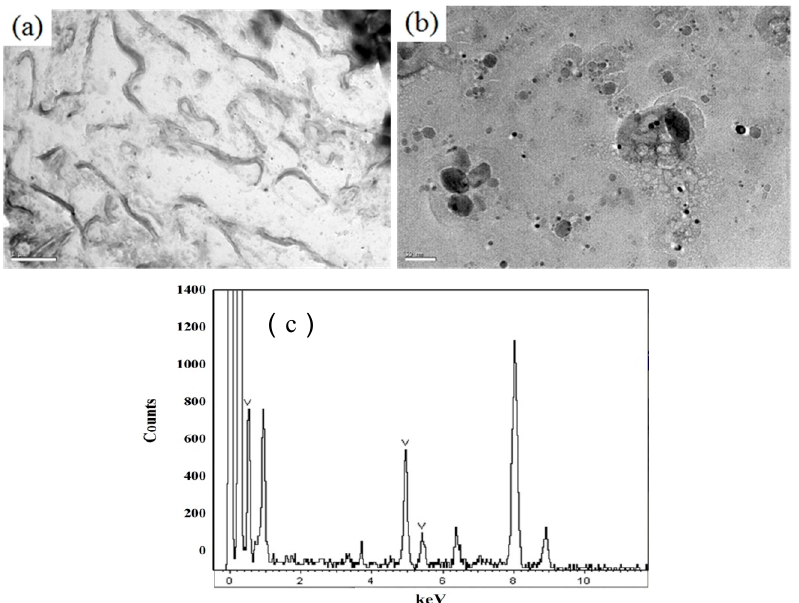
Figure 8. TEM observation of 0.21%V TAM steel: ( a ) Microstructure, ( b ) Precipitate, ( c ) EDS result indicating V precipitates.